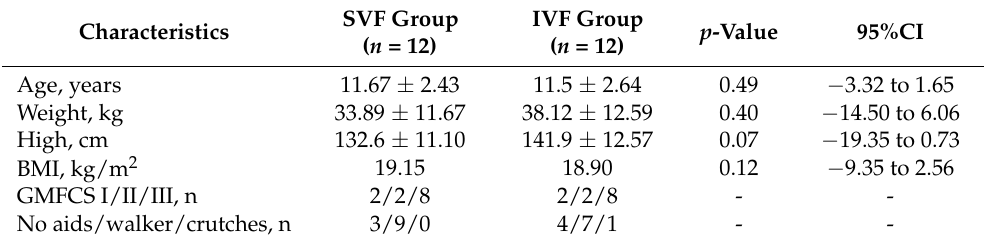
Table 2. Participant